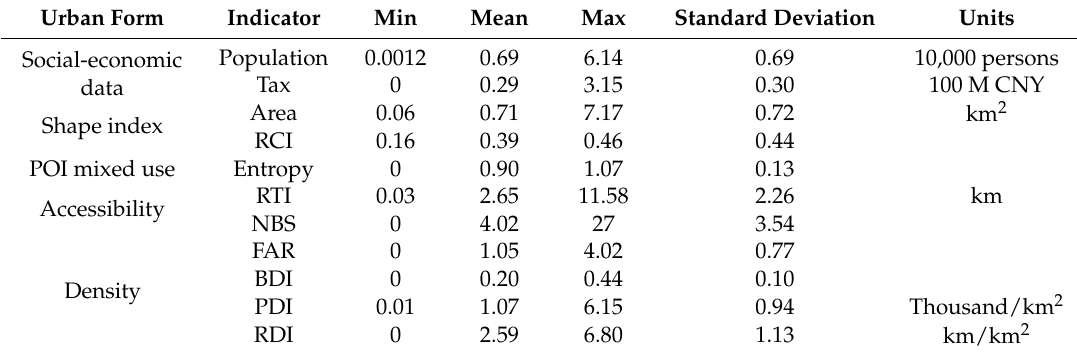
Table 3. Characteristics of urban form in neighborhood variables.